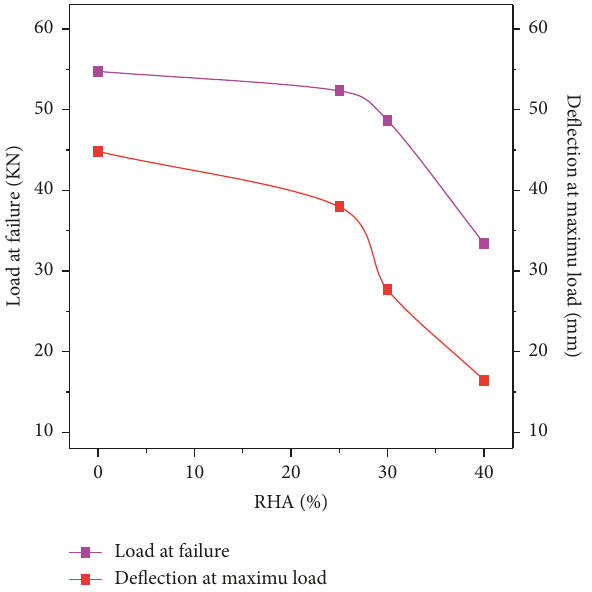
Figure 23: Flexural strength of concrete beams containing RHA [56].